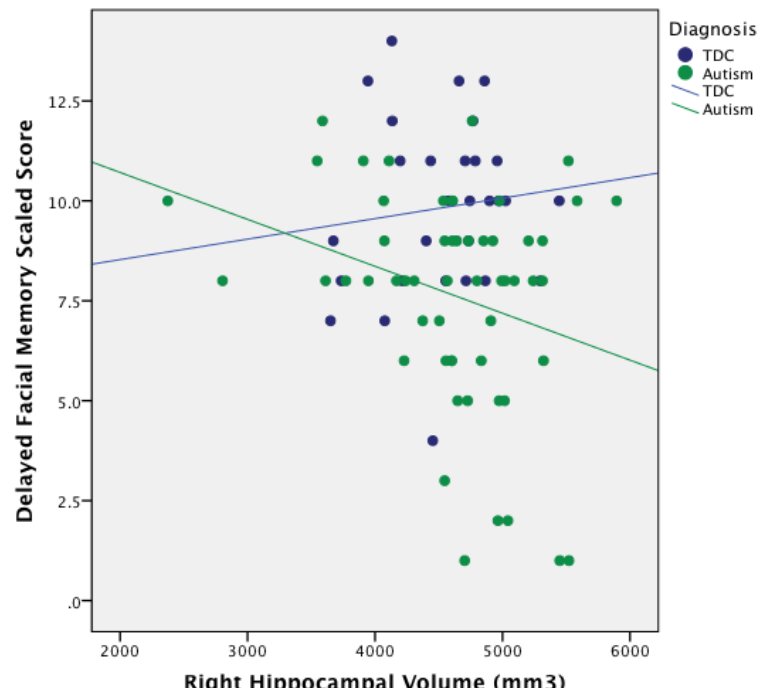
Figure 2. Relationship between Right Hippocampal Volume and Delayed Facial Memory Performance in